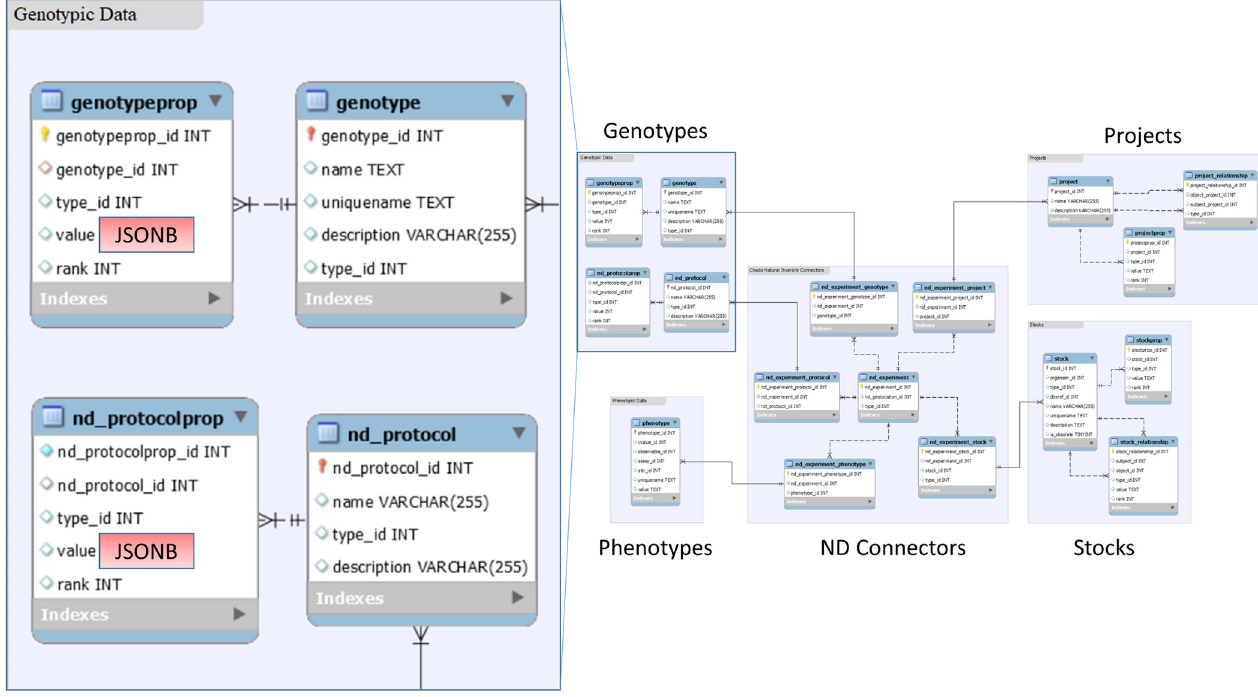
Fig 1. Core Chado database schema relied upon by Breedbase. The modifications for non-relationally storing genotyping data within the Chado relational schema are highlighted in red [17].